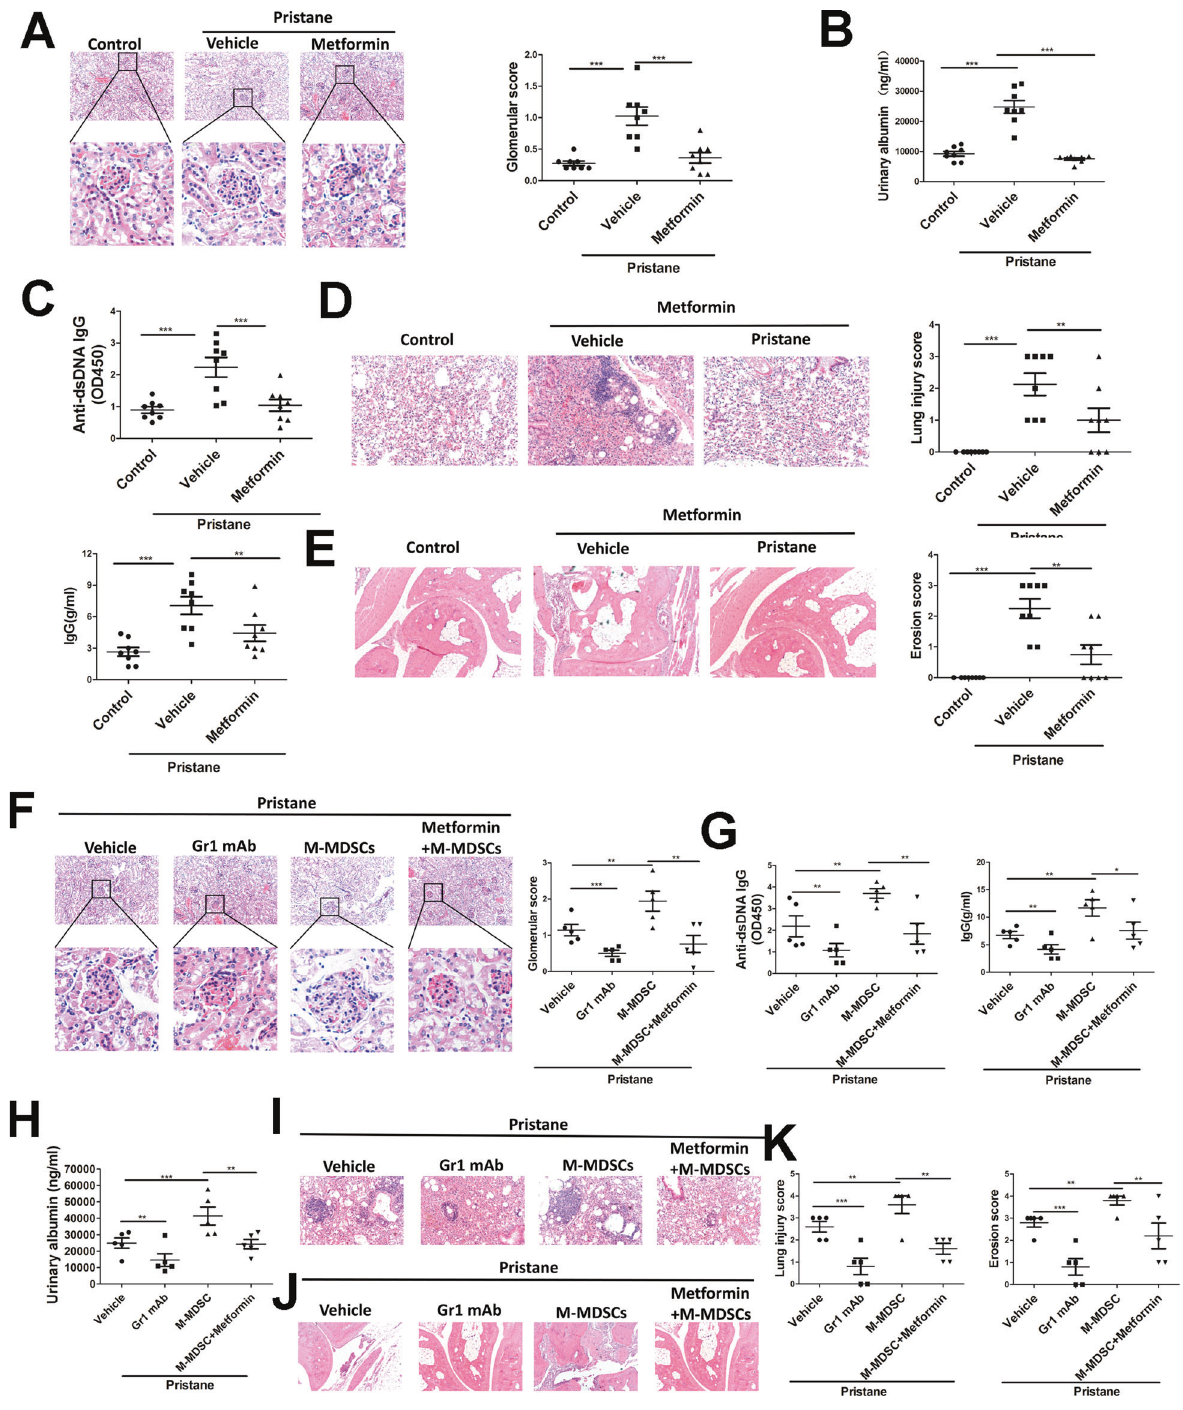
Fig. 2 AMPK signal activation could attenuate lupus symptoms by regulating M-MDSCs differentiation in pristane-induced lupus mice. BALB/c mice (10 weeks, n = 6 – 8/group) were given a single intraperitoneal injection of 0.5 ml pristane or PBS and monitored for 7 months. Metformin-treated lupus mice for 2 months after 5 months pristane injection. A Kidney sections from each group showed histologic differences. B Proteinuria in each group was determined using Mouse Albumin ELISA Quantitation Set. C Serum levels of total IgG and IgG against dsDNA were determined by ELISA. D Lung sections from each group showed histologic differences. E Representative photographs of paws from each group. F – K Gr1mAb, M-MDSCs or Metformin-treated lupus M-MDSCs treated mice for 1 month. F Kidney sections from each group showed histologic differences. G Serum levels of total IgG and IgG against dsDNA were determined by ELISA Quantitation Set. H Proteinuria in each group was determined using mouse albumin. I , K Lung sections from each group showed histologic differences. J , K Representative histological sections of tarsal hind paw joints. Data represent the mean ± SEM. * P ≤ 0.05, ** P ≤ 0.01, *** P ≤ 0.001.